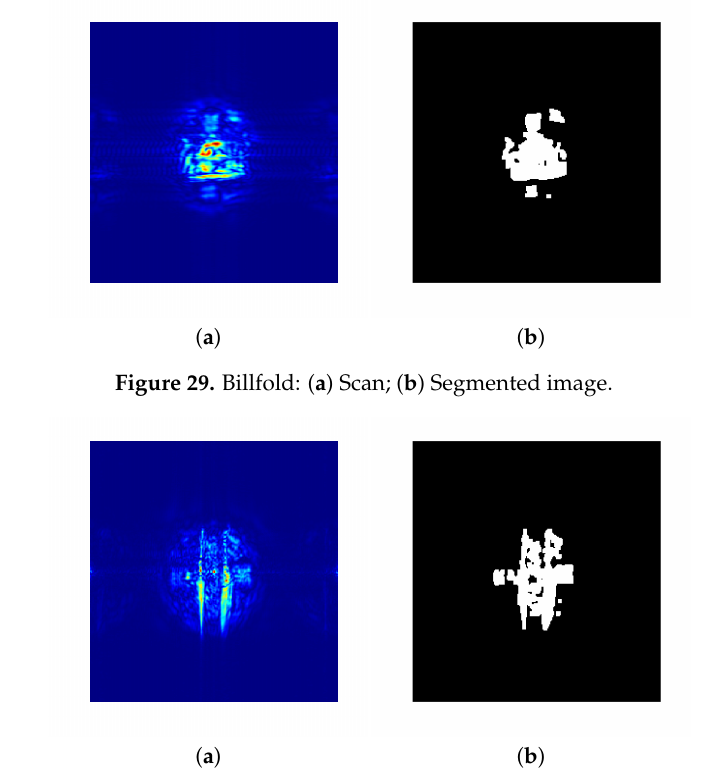
Figure 28. New set of keys: ( a ) Scan; ( b ) Segmented image.